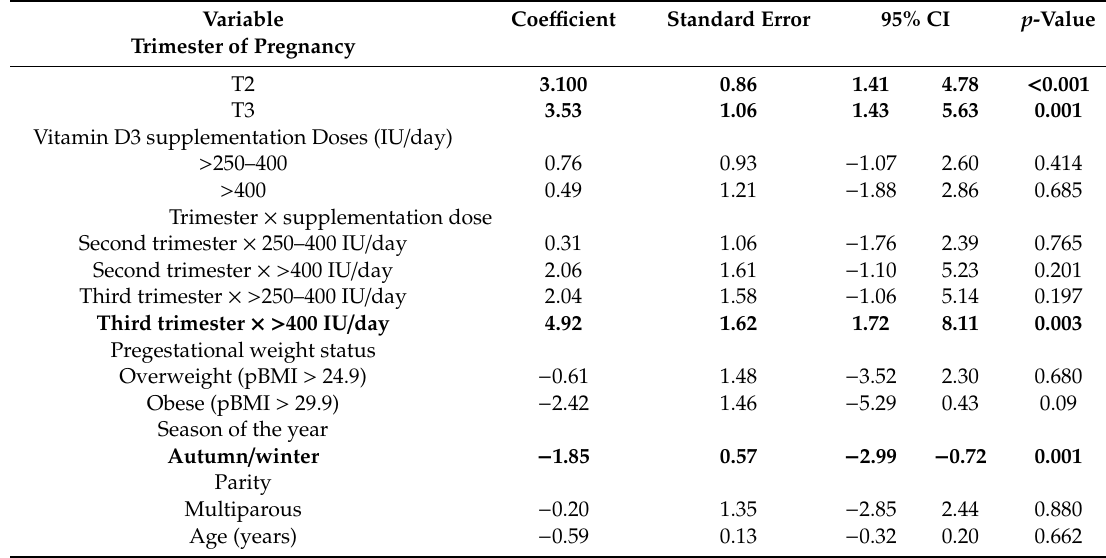
Table 2. E ff ect of vitamin D3 supplementation and doses of supplementation on maternal 25-OH-D concentrations (ng / mL) throughout pregnancy, adjusted for other